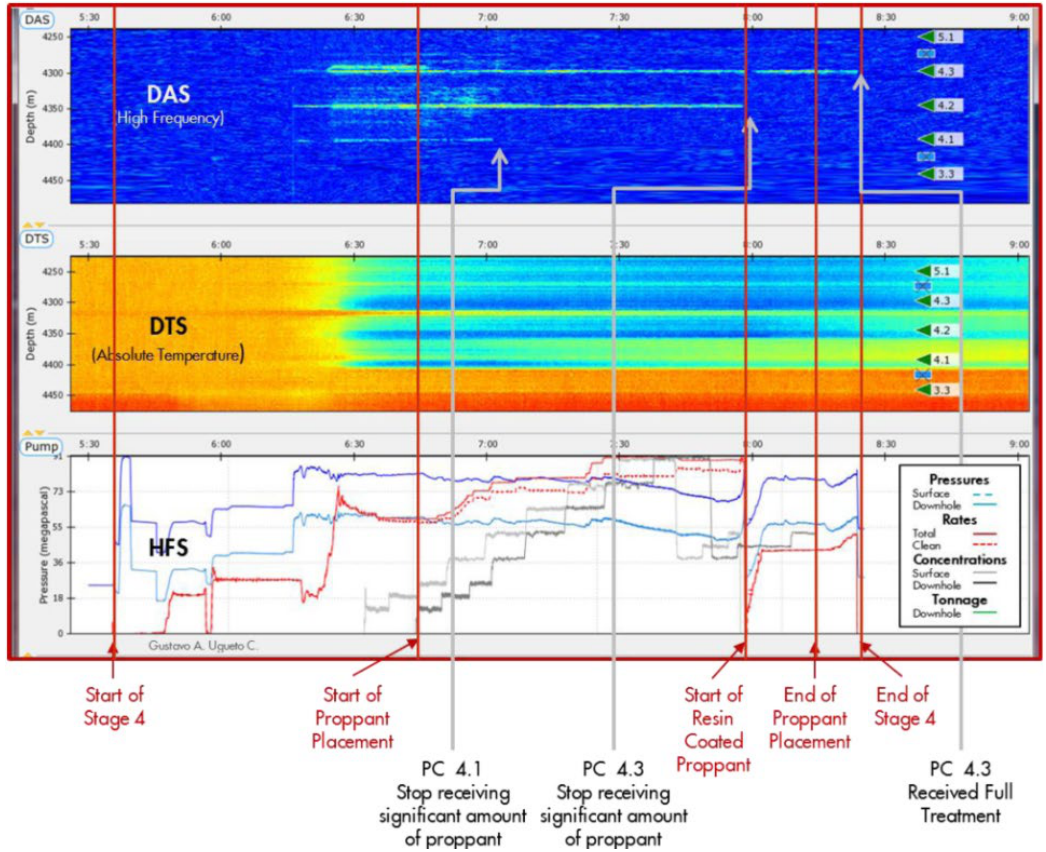
Figure 8. Example of DAS and DTS measurements during the hydraulic fracturing operation [36].